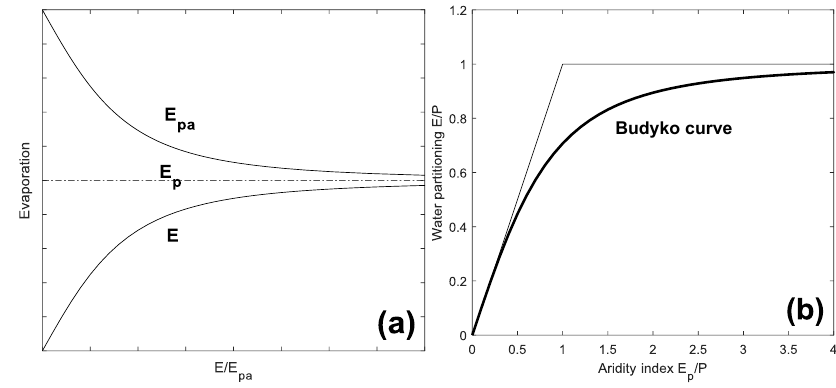
Figure 1. Conceptual representations of (a) the complementary relationship and (b) the Budyko framework. Table 1. Types of evaporation in the Budyko framework and the original CR, and their redefined evaporation type based on a generalized CR. The last column refers to the definitions of the three types of evaporation in the generalized CR provided in Brutsaert (2015). Budyko framework Bouchet’s complementary Generalized complementary Evaporation definitions relationship relationship in Brutsaert (2015) Actual evaporation ( E) Actual evaporation ( E) Actual evaporation ( E) The first type Potential evaporation ( E p ) Wet environment evaporation ( E 0 ) Potential evaporation ( E p ) The second type Potential evaporation ( E p ) “Apparent” potential evaporation ( E pa ) The third